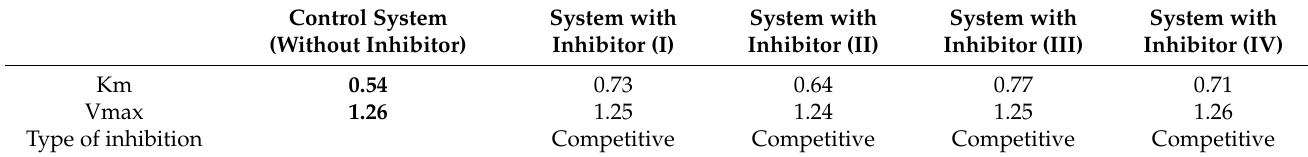
Table 3. Determination of the inhibition type for CAT by comparing the Km and Vmax values between the control systems without inhibitor and the systems containing inhibitors (I) (II), (III) and (IV) at a concentration of 20.00 mM. An increase of the Km value with a constant Vmax value in comparison to the basic system indicates the competitive type of inhibition for all compounds ((I), (II), (III) and (IV)).